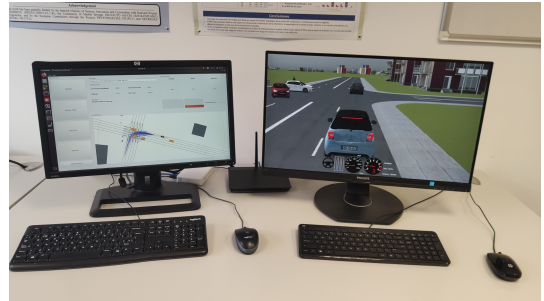
Figure 14. Simulation testing environment.